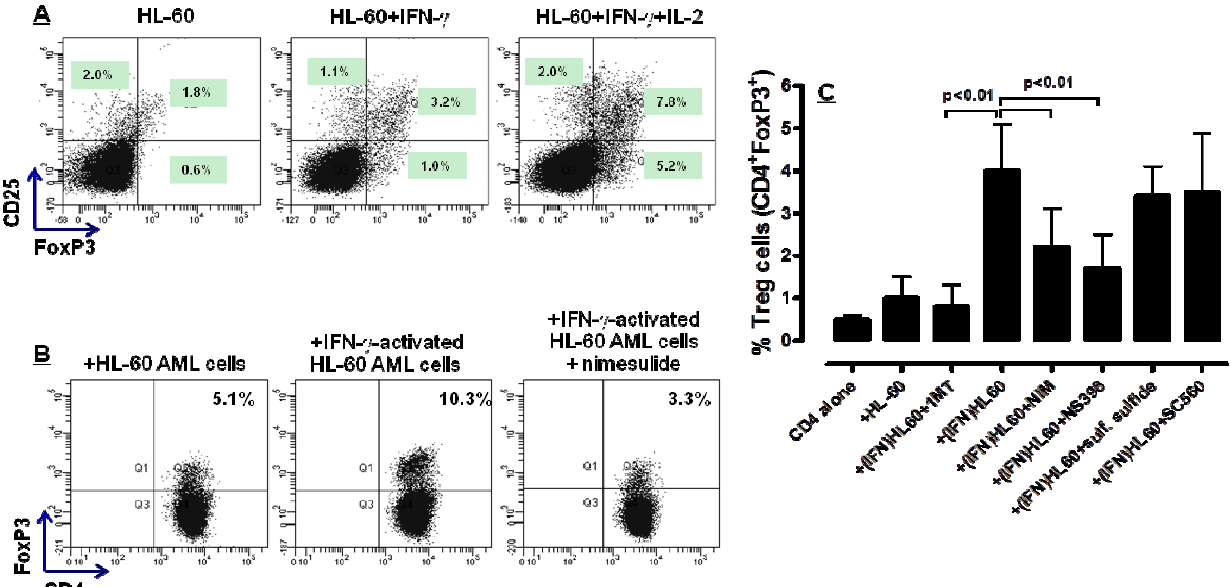
Figure 4. Effect of COX-2 inhibitors on leukaemia cell-induced differentiation of bona fide Treg cells. HL-60 cells were stimulated with 100 ng/mL IFN- γ for 72 h, followed by co-culture with allogeneic naive CD4 + CD25 − T cells for 5 days in a mixed tumour- lymphocyte culture (MTLC). Panel A: Expression of CD25 and intracellular FoxP3 after co-culture with HL-60 AML cells in a representative experiment. IL-2 was provided to the cultures as a Treg-specific growth factor. Panel B: Expression of intracellular FoxP3 by CD4 + T cells after co-culture with HL-60 AML cells either in the absence or presence of 100 mM nimesulide (one representative experiment is shown). Panel C: Cumulative results of co-culture experiments (n = 5), depicting the inhibition of Treg differentiation by AML cells that were also cultured with selective COX-2 (NS398) or COX-1 inhibitors (SC560, sulindac sulfide). In selected experiments, 1MT, a chemical inhibitor of IDO, was added at 200 μ M (final concentration) during the MTLC. Bars depict mean and